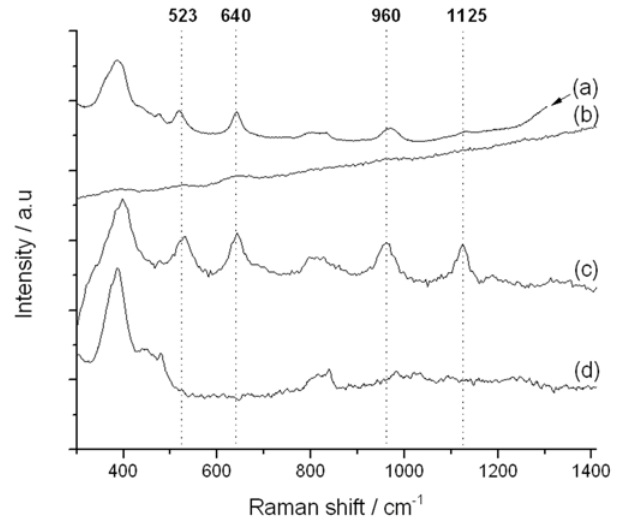
Figure 7. Impact of Raman excitation laser wavelength on Raman spectrum of